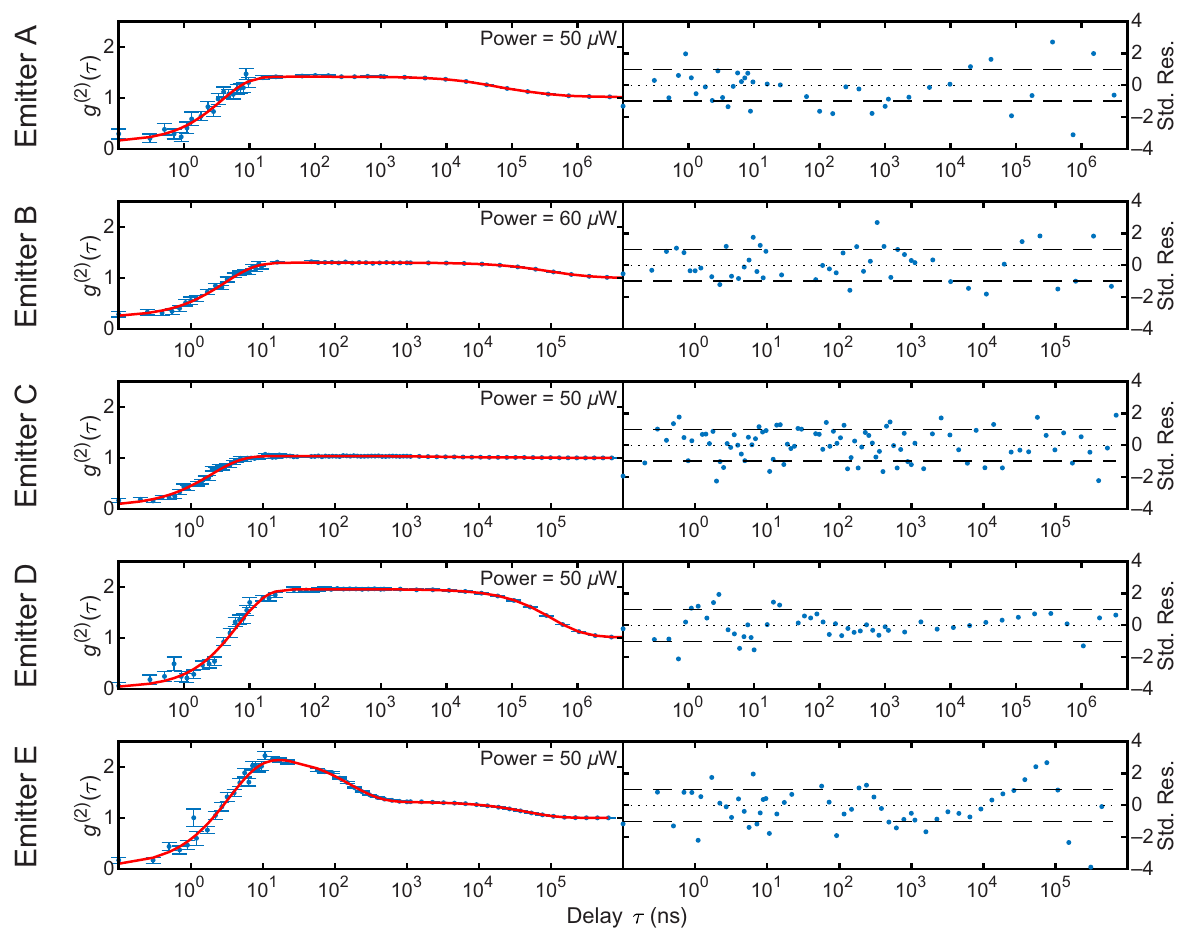
(τ) ; blue data points], binned exp (τ) ; red curve]. Error bars represent Poissonian fit (τ) − g ( 2 ) (τ) ] /σ (τ) . g exp fit